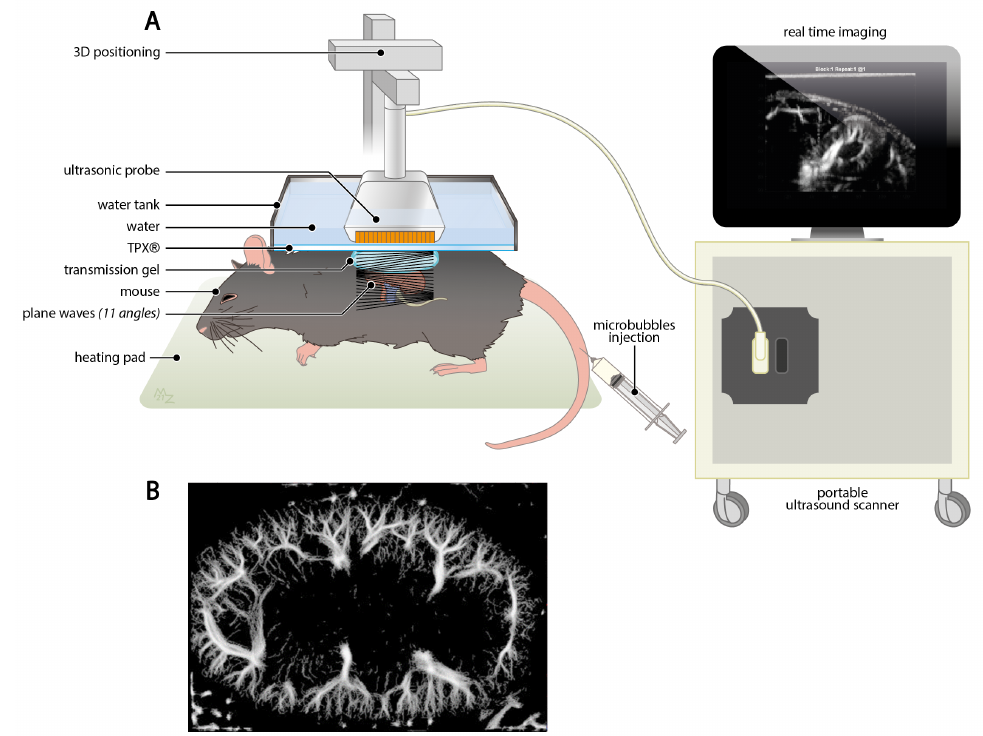
Figure 3. Ultrafast Doppler ultrasound imaging of the kidney is a highly promising technique to monitor renal microvascular rarefaction. ( A ) Schematic representation of experimental setup of ultrafast Doppler ultrasound imaging of the murine kidney. Portable ultrasound scanner is equipped with an ultrasonic probe that is operated through a 3 D positioning motor system for real time imaging. A 3D printed water tank reduces motion artifacts and ensures acoustic impedance matching through water, TPX ® , and transmission gel. To enhance the contrast, microbubbles are injected into the tail vein. ( B ) Representative image of renal ultrafast Doppler ultrasound imaging with injection of microbubbles to get access to capillary